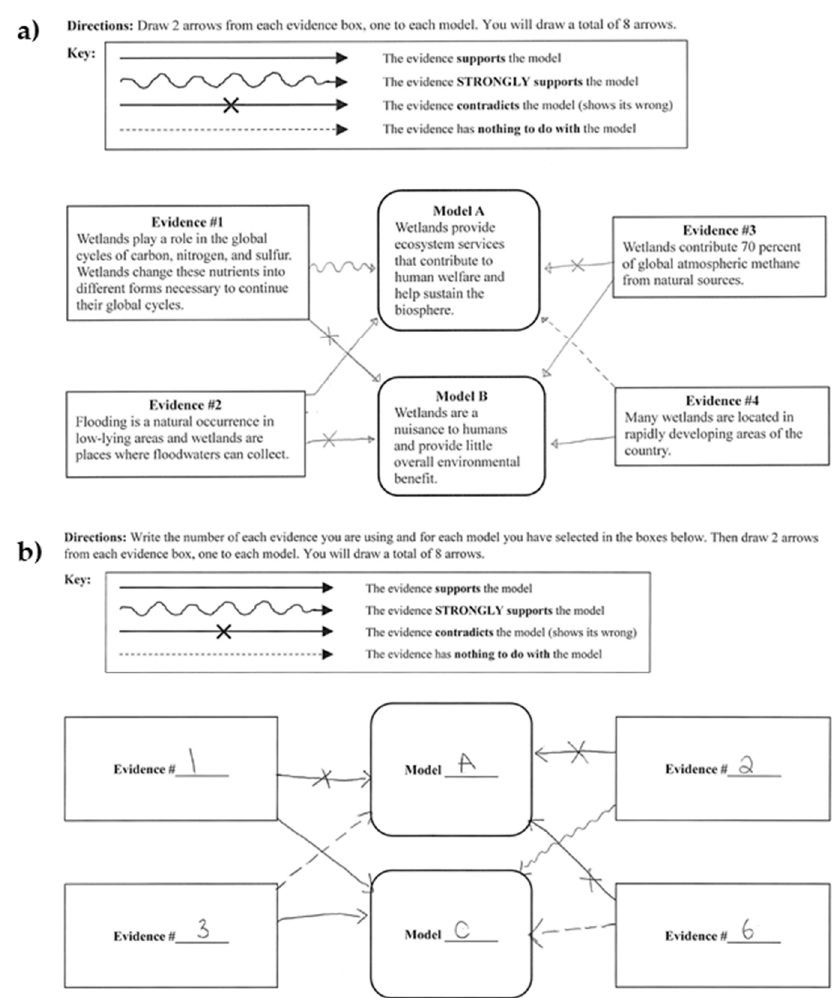
Figure 1. A student example of the wetland pre-constructed model–evidence link (pcMEL) ( a ) and the freshwater build-a-MEL (baMEL) baMEL ( b ) diagrams. Refer to Appendix A for more details on the lines of evidence and models in each instructional treatment.